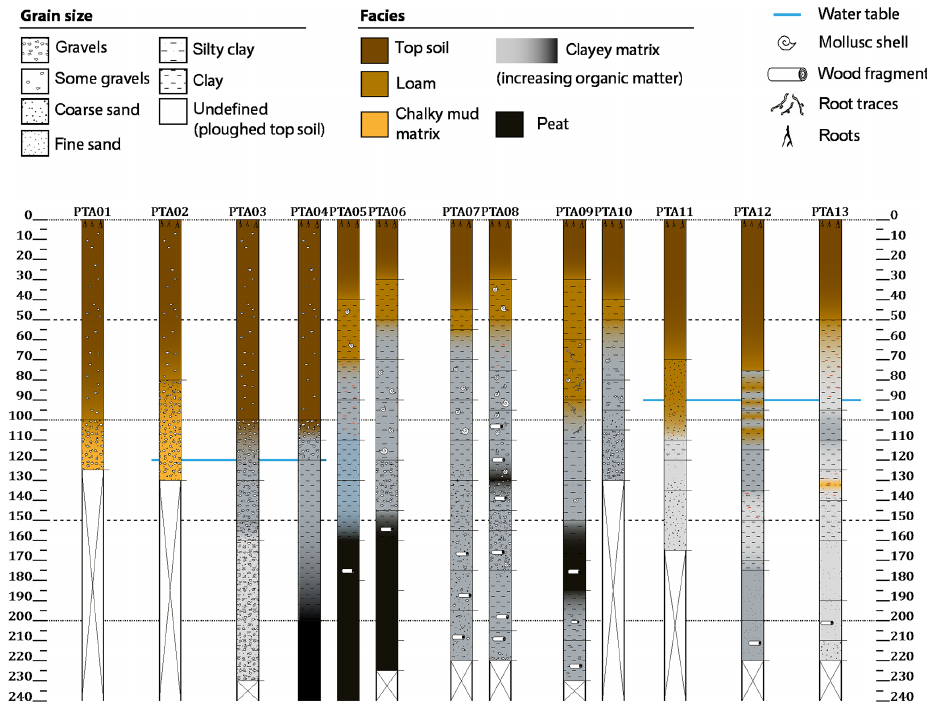
Figure 4. Log of hand auger soundings performed along the reference profile. The position of each sounding along the ERI profile is shown in Fig. 5.